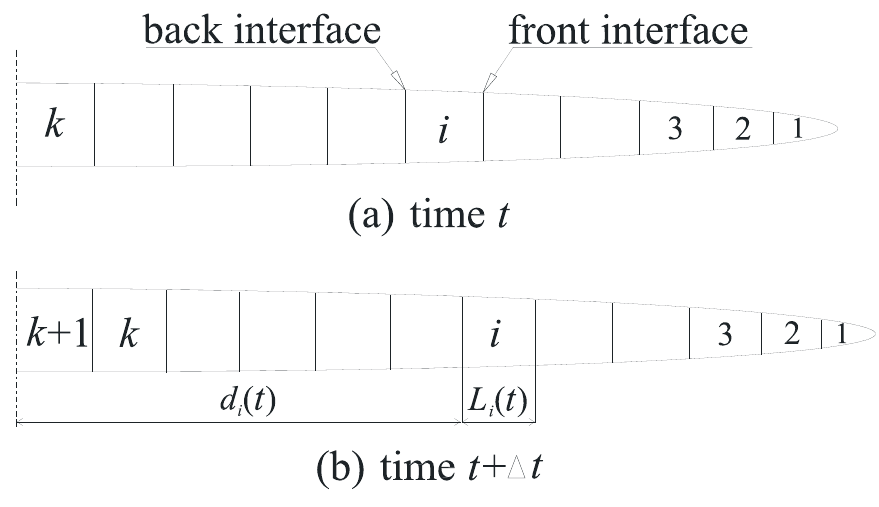
Figure 1. Schematic diagram of the fracture propagation